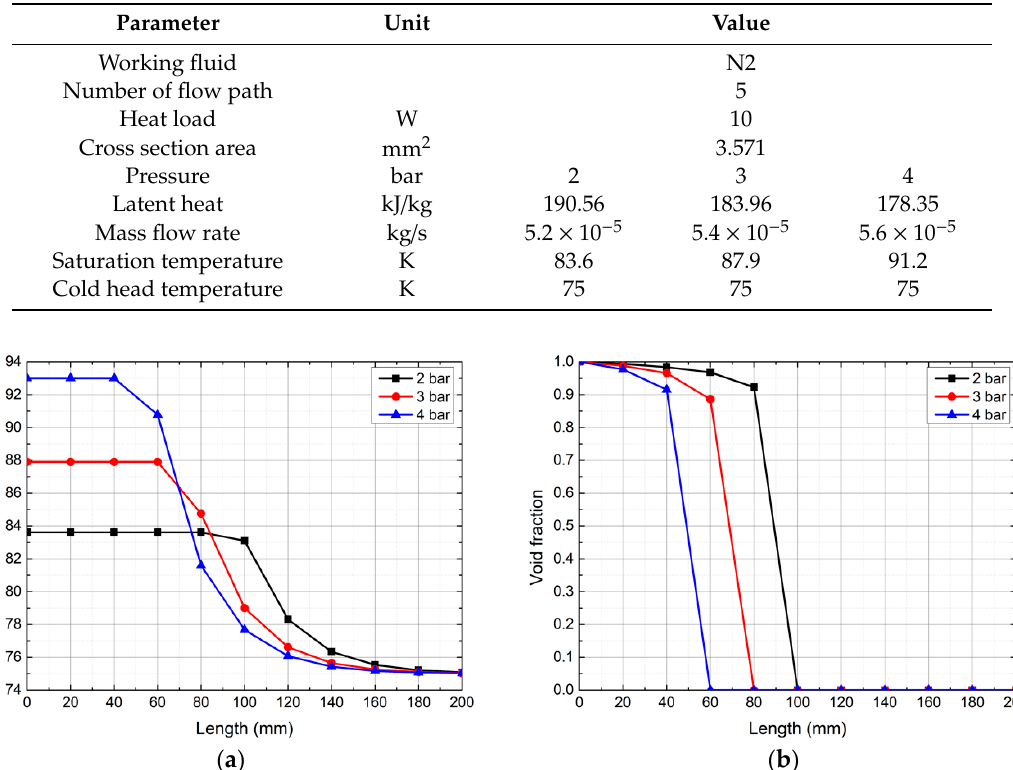
Table 3. Condition of 1D-node network analysis for calculation of cooling flow path length.